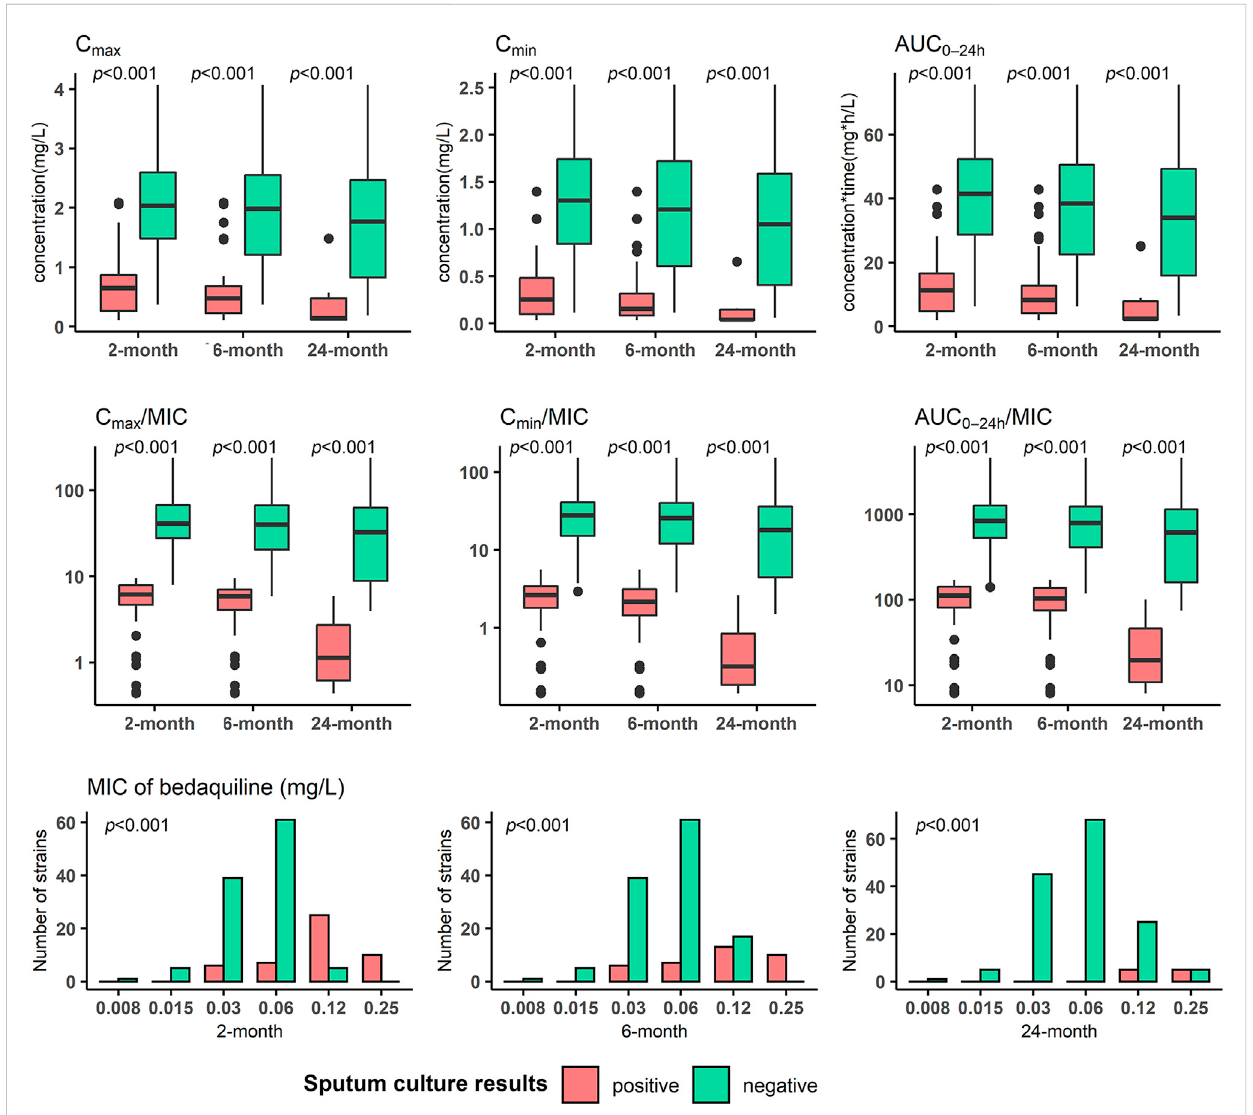
FIGURE 4 Distribution of bedaquiline exposure and susceptibility of Mycobacterium tuberculosis isolates respectively in participants with different treatment outcomes in the validation cohort. MIC: minimum inhibitory concentration; C max : maximum drug concentration; C min : minimum drug concentration; AUC 0-24h : area under drug concentration-time curve over the last 24 h dosing interval. Mann-Whitney U test was applied for